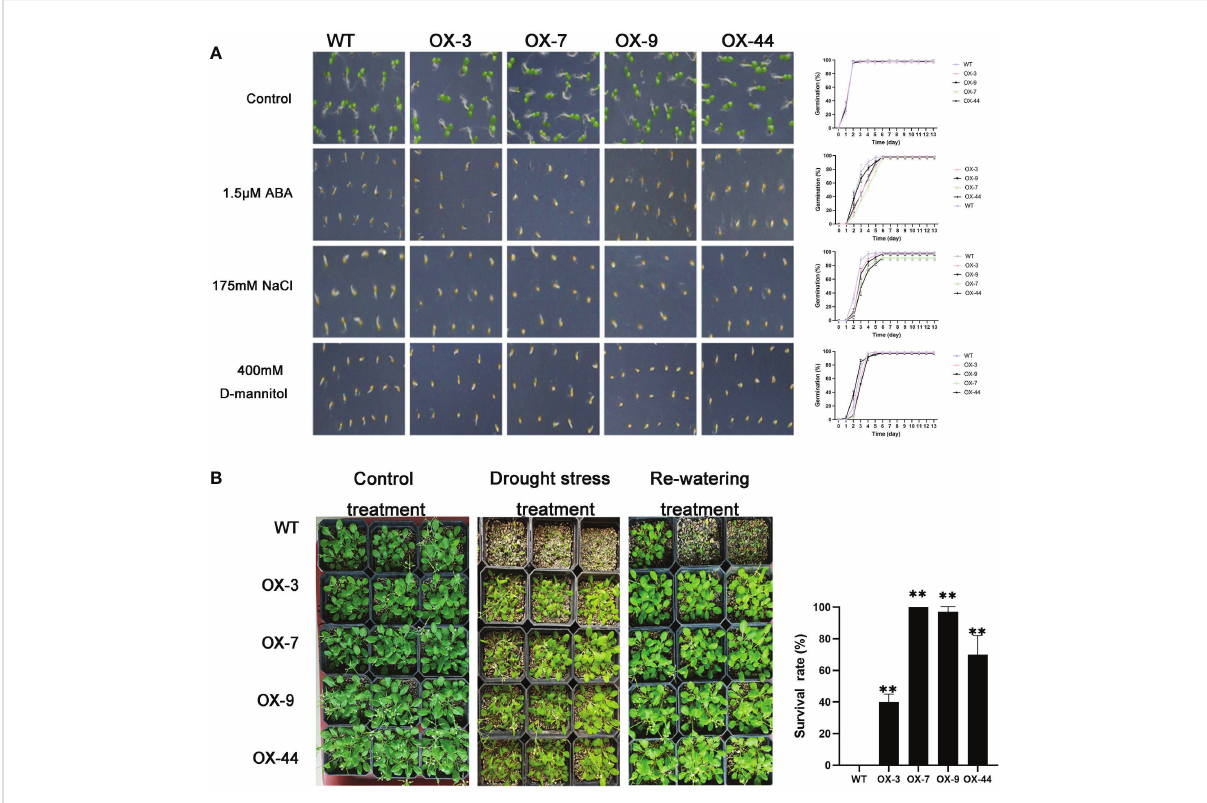
FIGURE 8 Germination and phenotype analysis ZmJUB1 overexpressing Arabidopsis. (A) Germination assays of ZmJUB1 were performed under the presence of 1.5 m M ABA and 175 mM NaCl and 400 mM D-mannitol. Each measurement consists of 50 seeds. Data are means ±SD of three biological replicates for 13 days. (B) Performance and survival rate of the ZmJUB1 overexpressing lines under drought stress and re-watering treatments. Three biological replicates and calculate the average. Highly signi fi cant differences (P < 0.01) were represented by